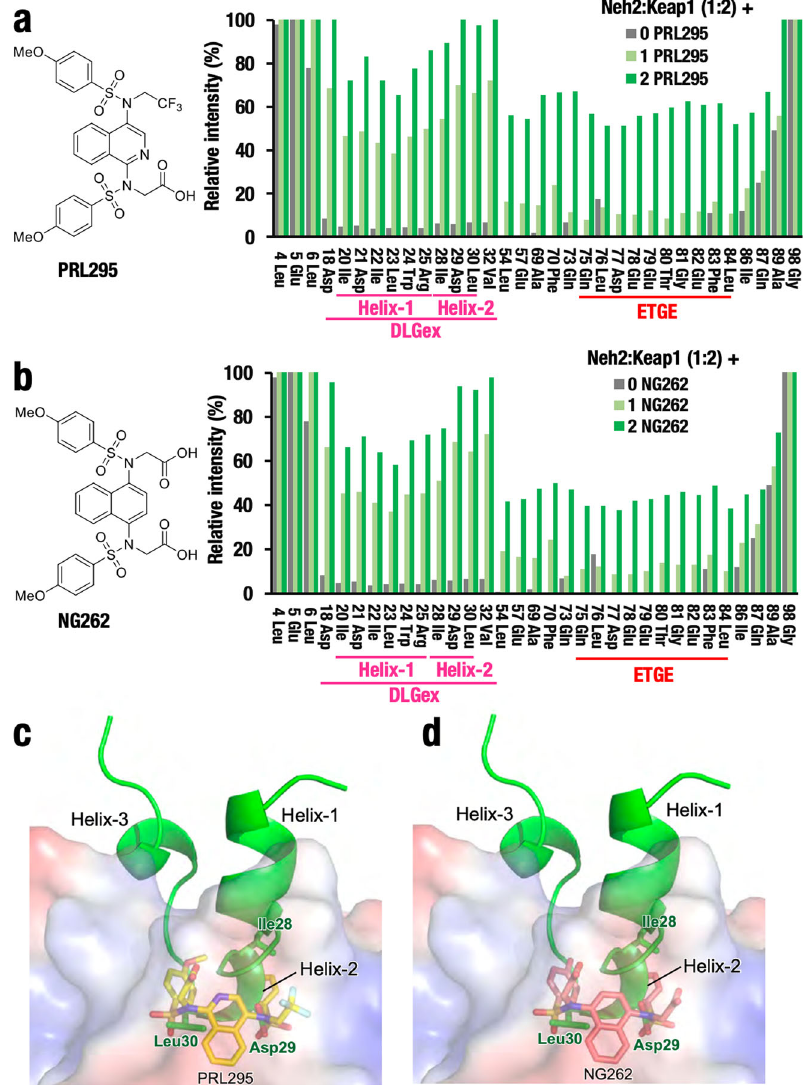
Fig. 4 Keap1 – Nrf2 PPI inhibitors preferentially inhibit the Keap1 – DLGex interaction. a , b NMR titration experiment of labeled Neh2 – Keap1 complex (1:2) by the addition of equal amount or twofold excess of PPI inhibitor, PRL295 ( a ) and NG262 ( b ). The relative peak intensity of the NMR signal of each residue was calculated (set at 100% for Neh2 only). c , d Merged images of DLGex with PRL295 ( c ) or NG262 ( d ) associating with Keap1 pocket. Image